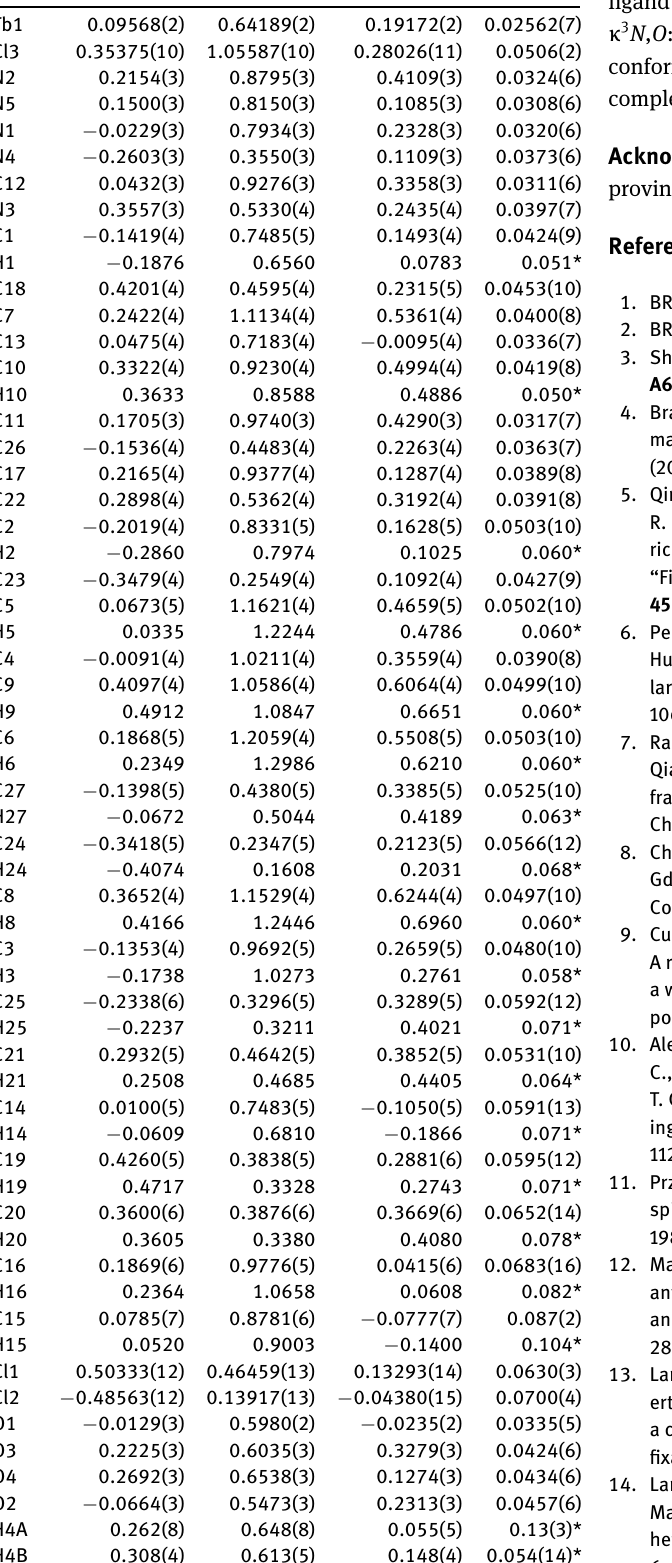
Table 2: Fractional atomic coordinates and isotropic or equivalent isotropic displacement parameters (Å 2